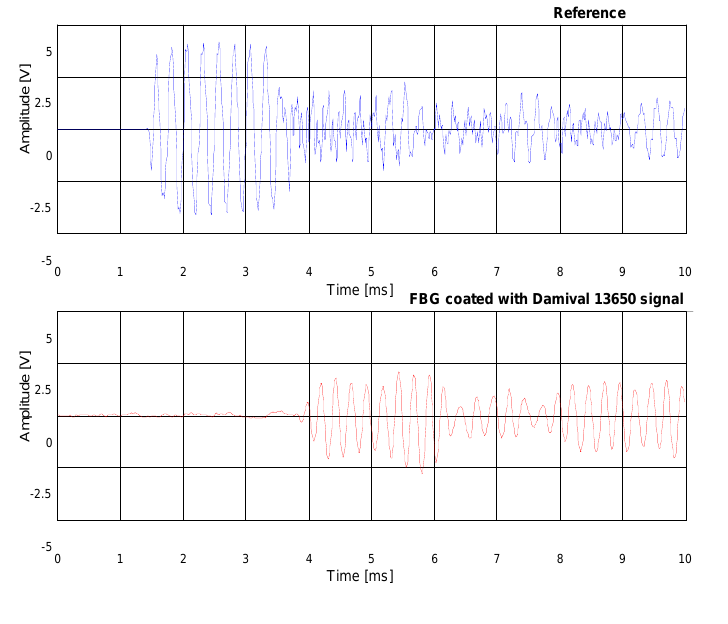
Figure 5 . Temporal response of the reference hydrophone (upper) and the fiber optical hydrophone coated with Damival 13650 (lower) to a sound pressure pulse at the frequency of 4 kHz and duration of 2